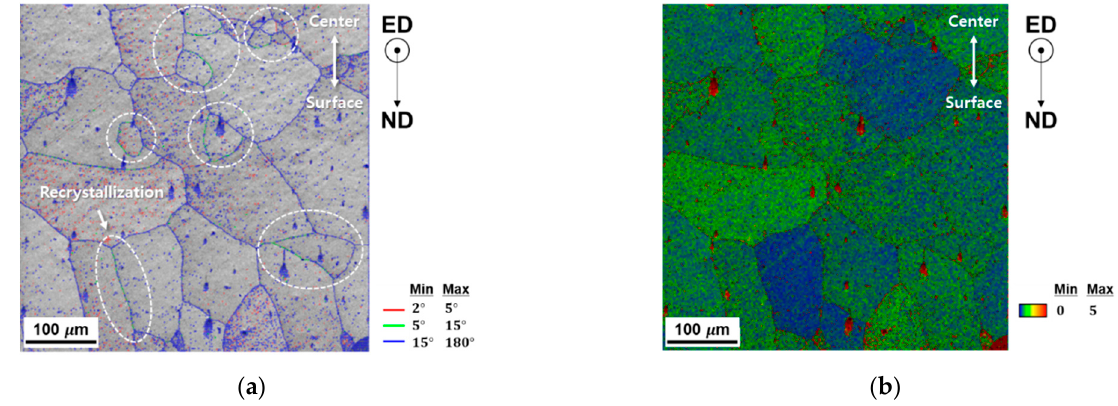
Figure 19. Distribution of: ( a ) the rotation angle; and ( b ) the kernel average misorientation of the defective region.